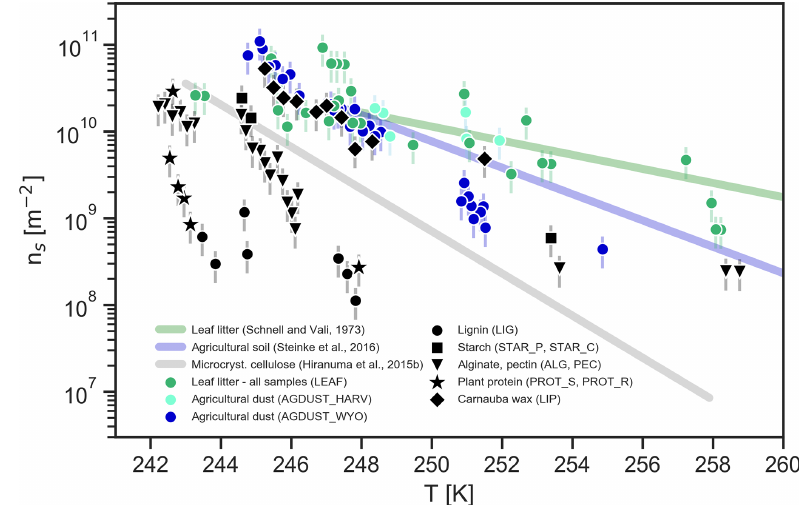
Figure 1. Immersion freezing results for plant-related organic compounds compared to ambient samples. Ice nucleation efficiency is ex- pressed as INAS density values based on AIDA cloud chamber